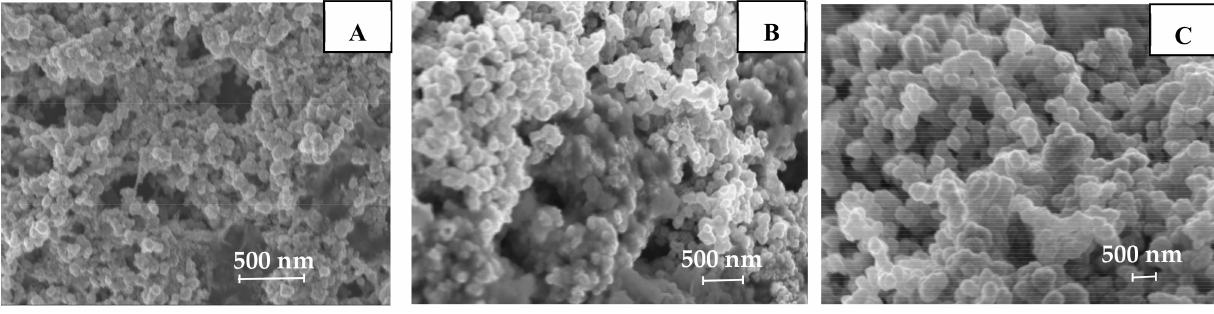
Figure 5. Scanning Electron Microscopy (SEM) images of Ni-Ag NPs with the size distribution of about 100 ( A ); 220 ( B ) and 420 nm ( C